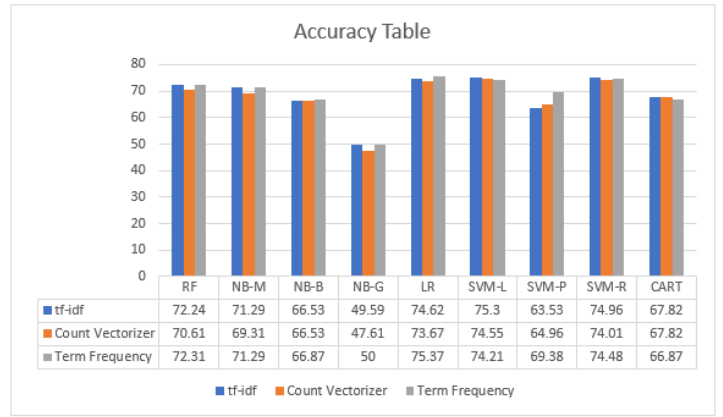
Figure 3. Bar graph showing accuracies on Kabita’s Kitchen dataset using tf-idf, count and term frequency vectorizer.